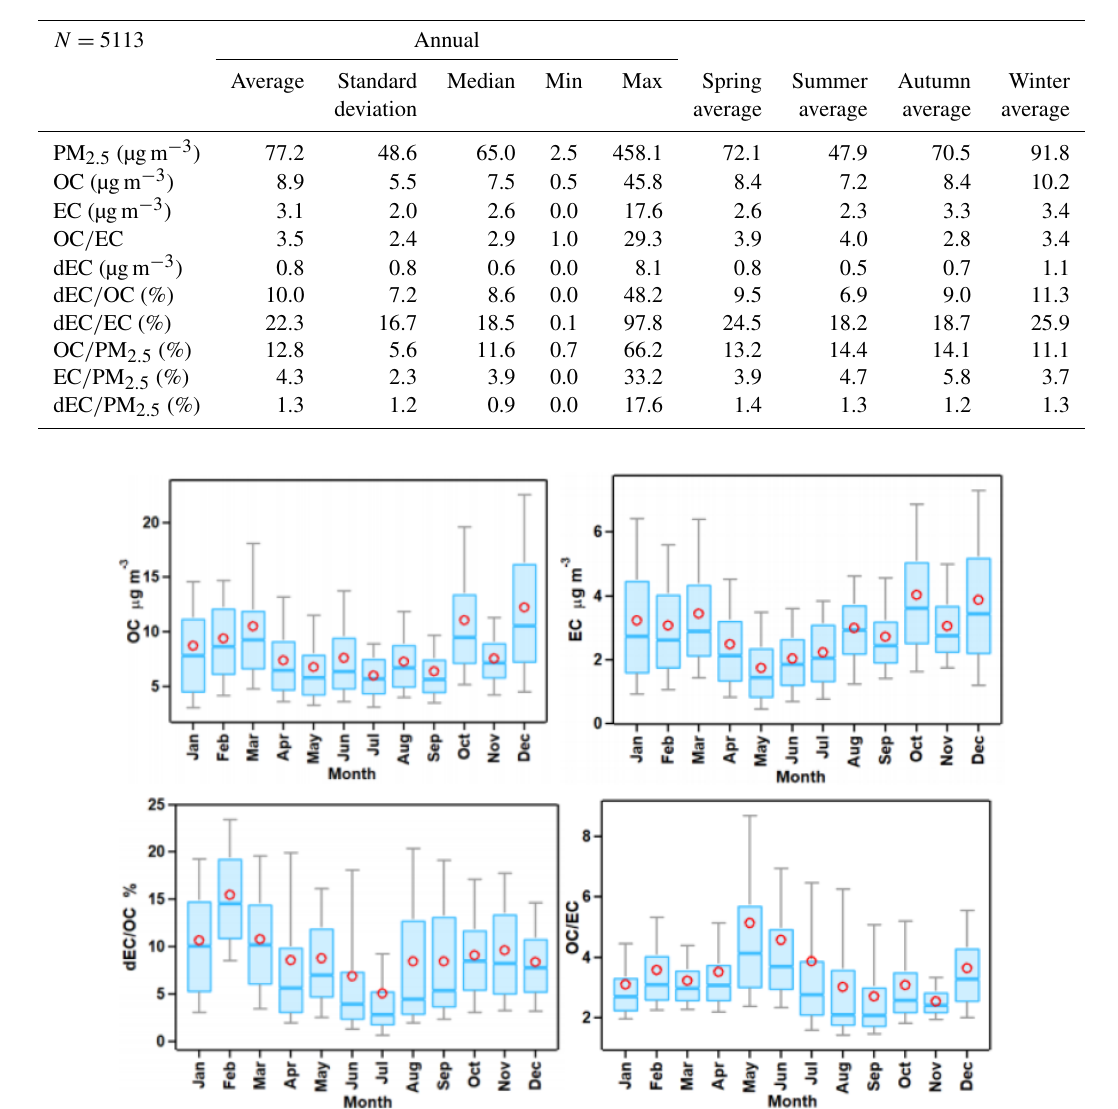
Table 1. Statistical summary on the PM 2 . 5 and carbon species concentrations.